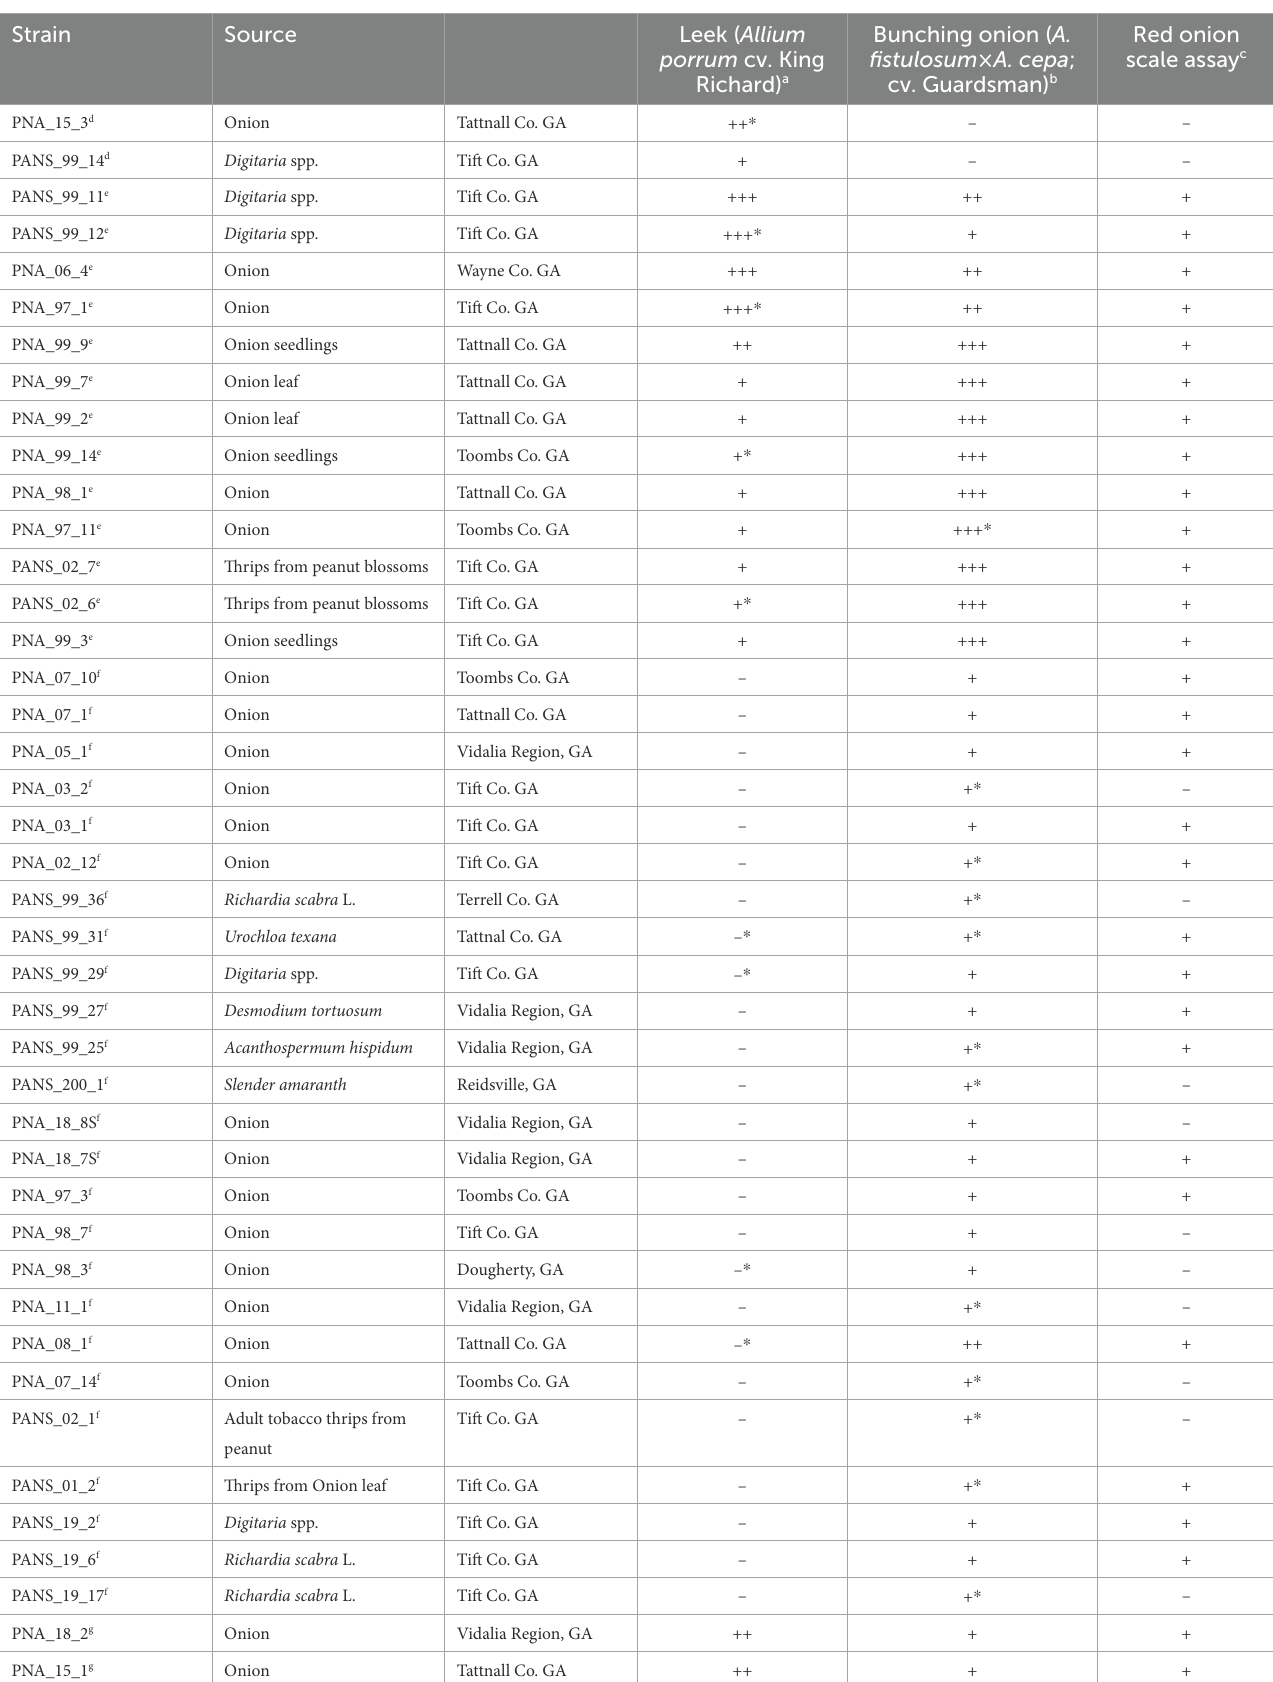
TABLE 1 Pantoea ananatis strains, their source of isolation, and their associated pathogenicity and aggressiveness on leek ( Allium porrum ) and Japanese bunching onion ( Allium fistulosum × Allium cepa ) and their phenotype on red onion scale. Strain